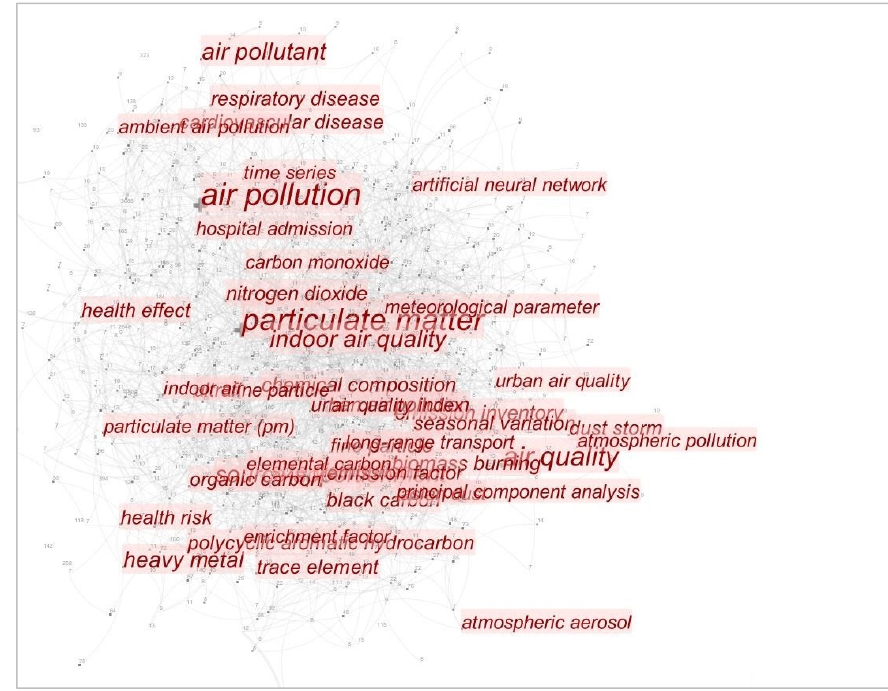
Figure 2. Visualization of author keywords. Minerals 2021 , 11 , x FOR PEER REVIEW